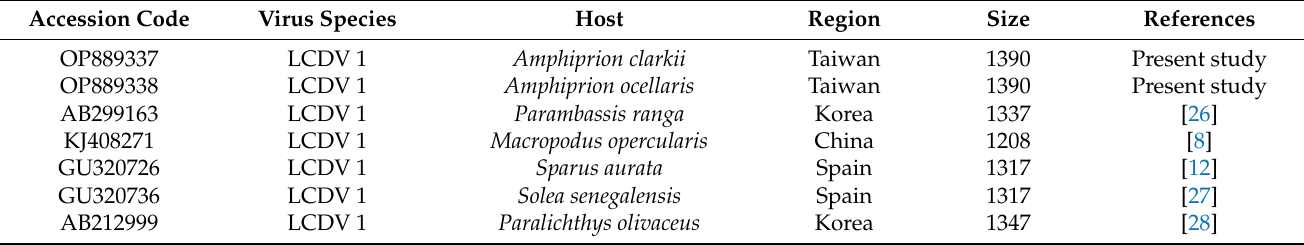
Table 1. List of the MCP region sequences used in phylogenetic